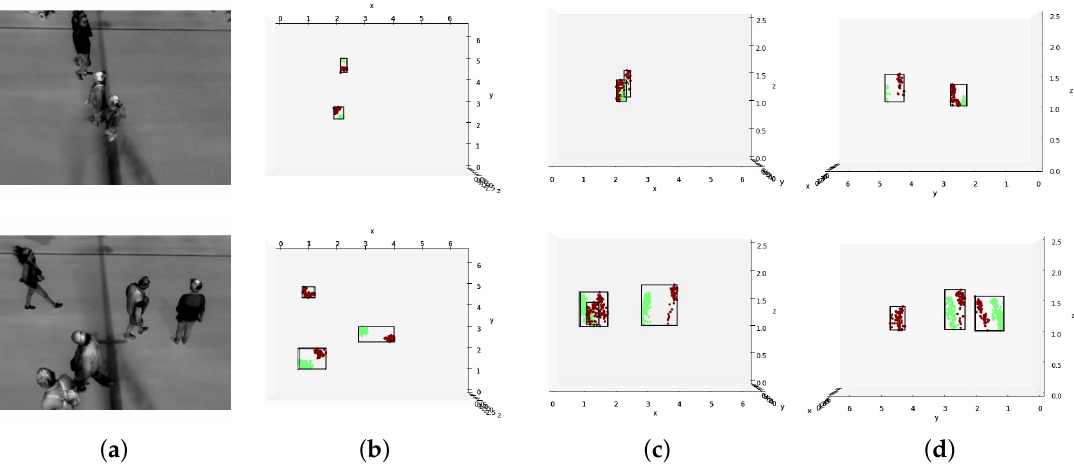
Figure 4. Examples of detected groups and pedestrians. The upper row presents one example, the bottom row another. Each group is shown within a bounding box and each pedestrian in the group is represented by a different color. ( a ) are the undistorted left input images; ( b ) are top-down views of the reconstructed scene; ( c ) are views from the base of the camera position; ( d ) are views along the